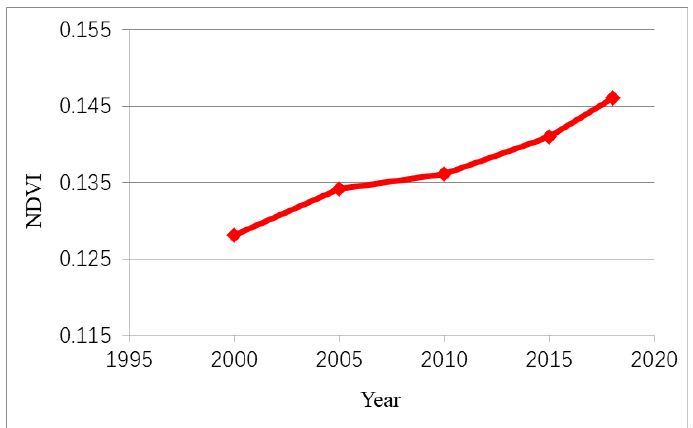
. Figure 3. Normalized Di ff erence Vegetation Index (NDVI) changes of vegetation in growing season in Figure 3. Normalized Difference Vegetation Index (NDVI) changes of vegetation in growing season west China in 2000 / 2005 / 2010 / 2015 / 2018. in west China in 2000/2005/2010/2015/2018.